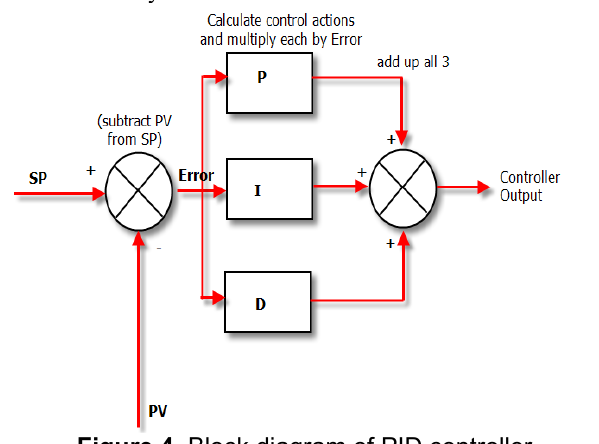
Figure 4. Block diagram of PID controller